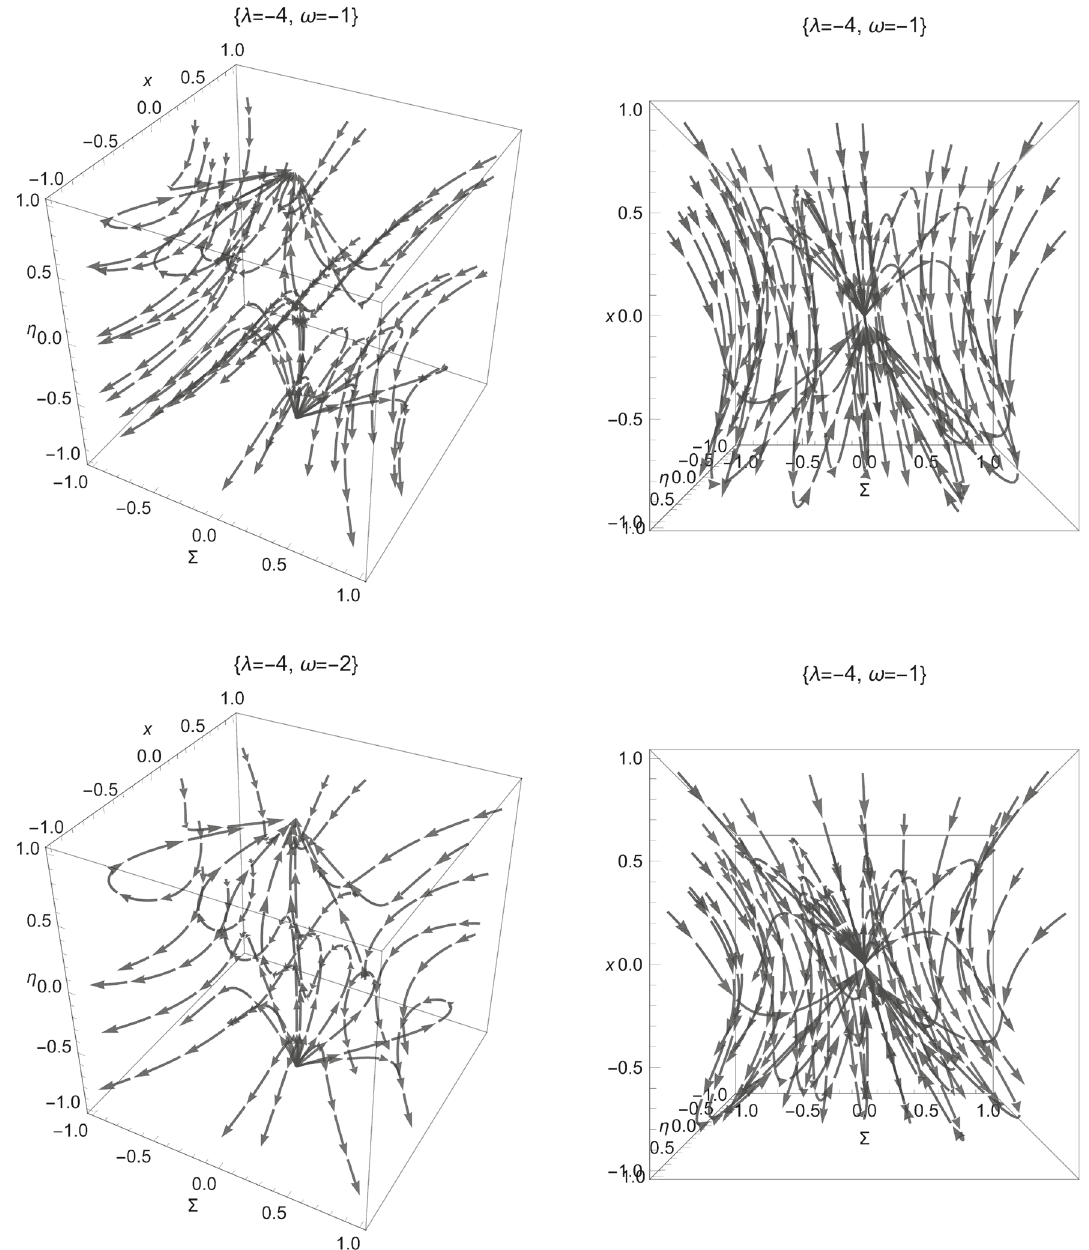
Fig. 6 Phase-space portraits for the dynamical system for the power- law potential in the three-dimensional space ((cid:14), x ,η). Plots are for ω < 0 and ων > 0. It is clear that the de Sitter point Q +